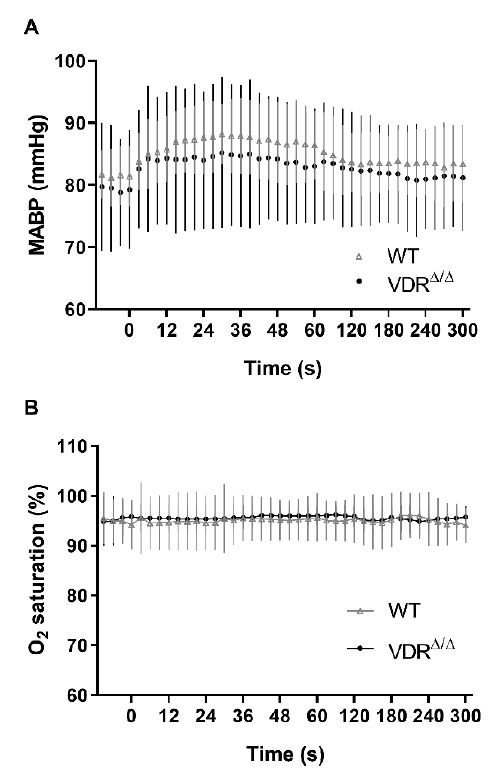
Figure 4. Physiological parameters of mice during the cerebrocortical blood flow measurement. ( A ) The mean arterial blood pressure (MABP) and ( B ) the O 2 saturation were within the physiological range throughout the experiments, and carotid artery occlusion induced only a minor increase in the MABP. Zero time indicates the moment of the left carotid artery occlusion. Neither parameters were different between the groups ( n = 8 in both groups, two-way repeated measures ANOVA followed by Bonferroni post hoc test). Data are presented as mean ± SD. Table 2. Arterial blood gas and acid-base parameters.